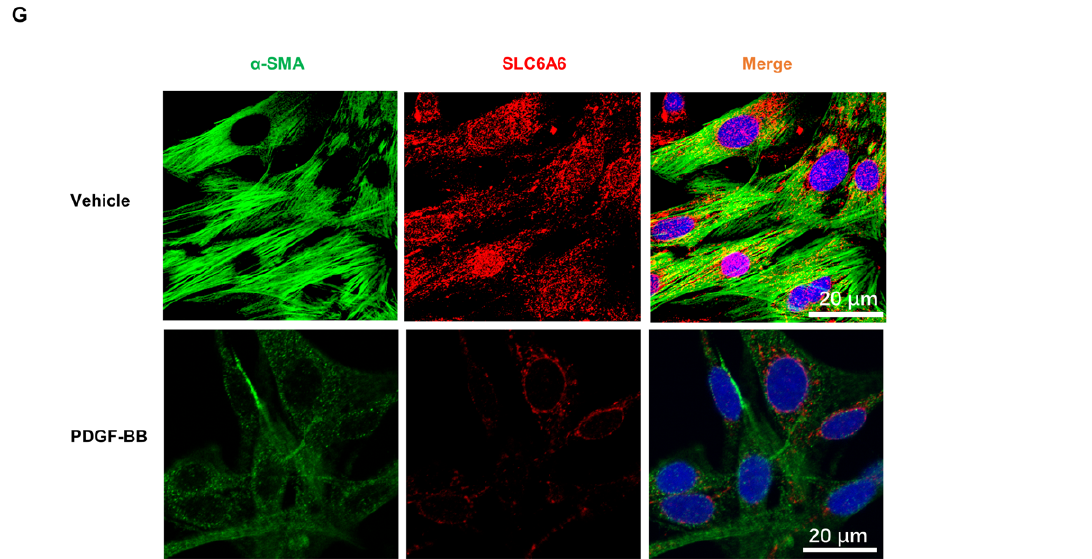
Figure 1. SLC6A6 was downregulated during VSMC dedifferentiation. ( A , B ) Quantitative real‑time polymerase chain reaction (qRT‑PCR) showing the mRNA levels of SLC6A6, VSMC‑specific genes ( α ‑SMA and SMMHC), and cyclin D1. VSMCs were stimulated with PDGF‑BB (25 ng/mL, 50 ng/mL) or 20% FBS. Data were normalized to GAPDH. N = 3; * p < 0.05, ** p < 0.01 vs. vehicle. Data are represented as mean ± SD. ( C , D ) qRT‑PCR and Western blot analyses showing the time‑dependent changes in SLC6A6 mRNA and protein levels after PDGF‑BB stimulation (50 ng/mL). Data were normalized to GAPDH (PCR) and β ‑actin (Western blotting). N = 3; * p < 0.05, ** p < 0.01 vs. 0 h. Data are represented as mean ± SD. ( E , F ) Concentration‑dependent changes in SLC6A6 and α ‑SMA, CNN1, SM22 α , and cyclin D1 protein levels after 24 h of PDGF‑BB stimulation (0, 25, 50, and 100 ng/mL). N = 3; * p < 0.05, ** p < 0.01 vs. 0 ng/mL. Data are represented as mean ± SD. ( G ) Representative images of dual immunofluorescence staining of SLC6A6 (red) and α ‑SMA (green) in vehicle (PBS) and PDGF‑BB (50 ng/mL)‑stimulated VSMCs, scale bar: 20 µ m (600 ×